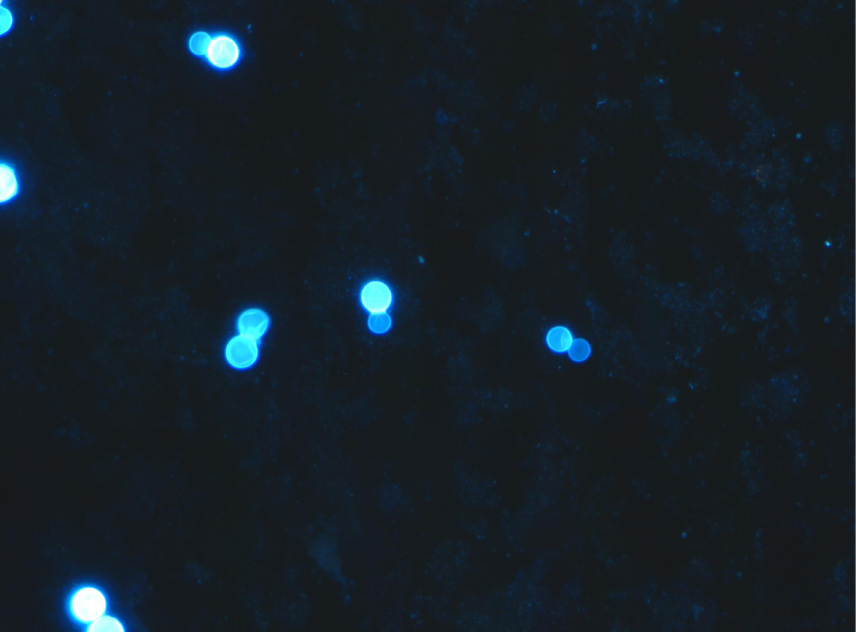
Figure 2. Calcofluor white stain of bronchoalveolar lavage fluid from a patient with severe pulmonary blastomycosis highlighting multiple thick-walled broad-based budding yeasts (40× magnification).